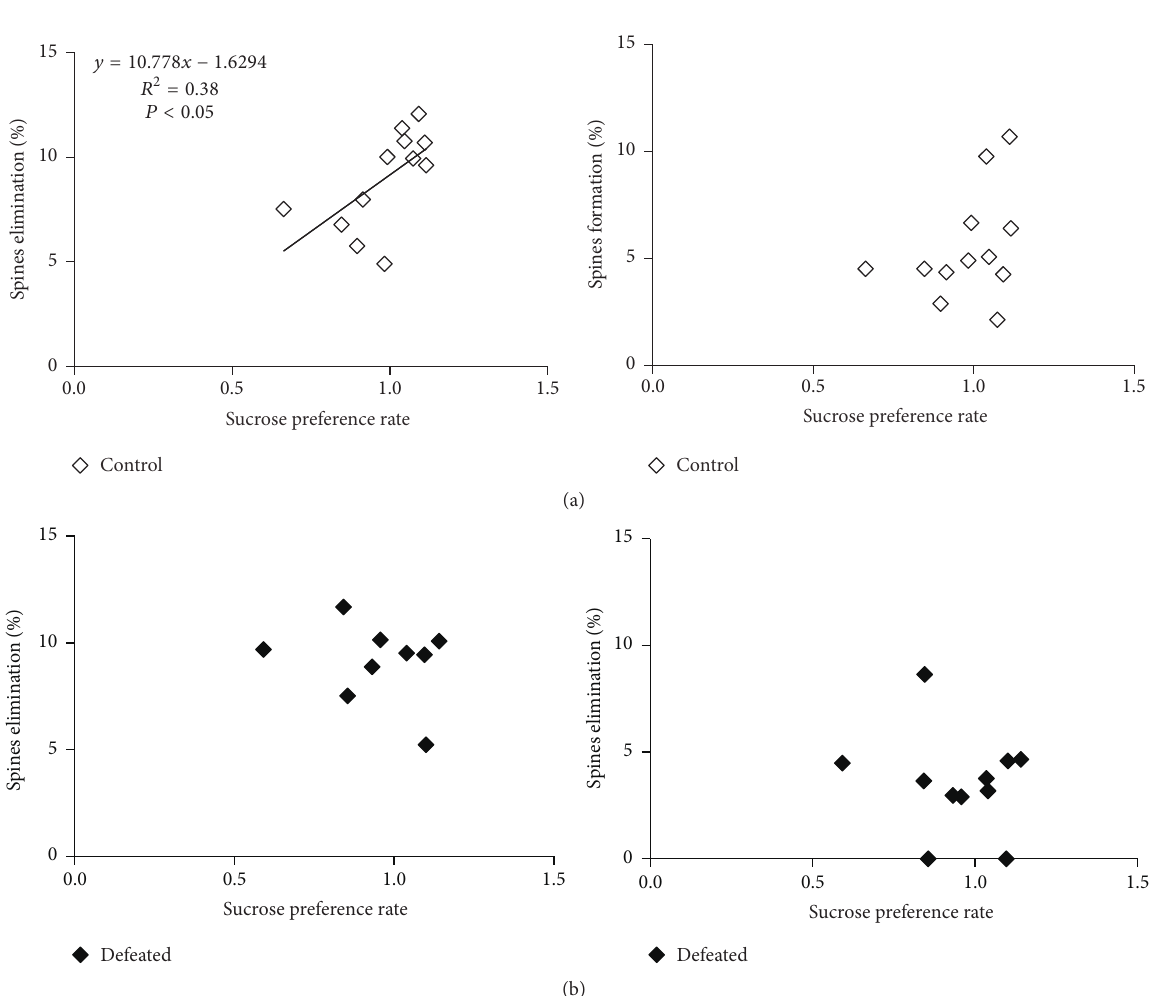
Figure 5: CSDS changed correlations between sucrose preference and spine dynamics in FrA. (a) Percentage of spine elimination rather than formation of control mice during day 0–day 10 was linearly correlated with sucrose preference rate ( 𝑛 = 12 ; linear regression analysis: elimination: 𝑅 2 = 0.38 , 𝑃 = 0.032 and formation: 𝑅 2 = 0.13 , 𝑃 = 0.26 ). (b) Percentage of spine elimination and formation of defeated mice during day 0–day 10 were both not correlated with sucrose preference rate ( 𝑛 = 11 ; linear regression analysis: elimination: 𝑅 2 = 0.02 , 𝑃 = 0.68 and formation: 𝑅 2 = 0.04 , 𝑃 = 0.58